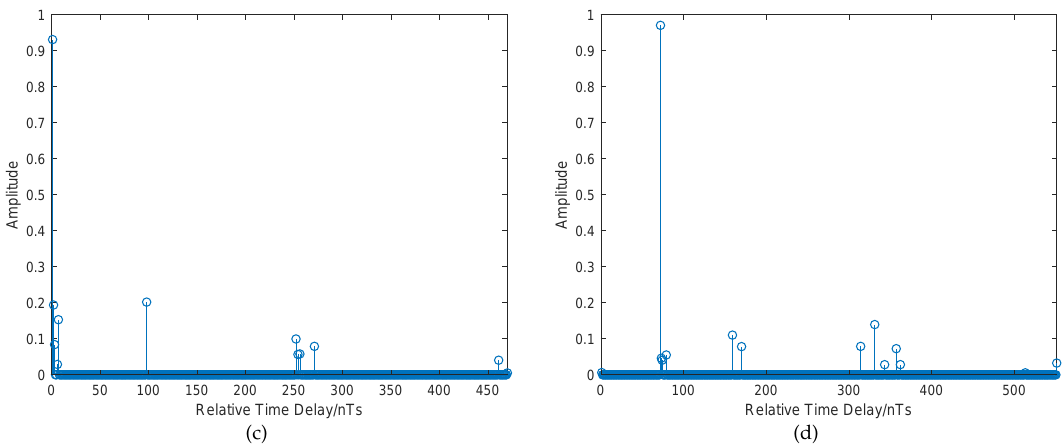
Figure 13. Normalized CIRs of channel with different sea surface boundaries in 1.29 m SWH. Sea surface boundaries of each figure: ( a ) Sea Surface 1; ( b ) Sea Surface 2; ( c ) Sea Surface 3; ( d ) Sea Surface